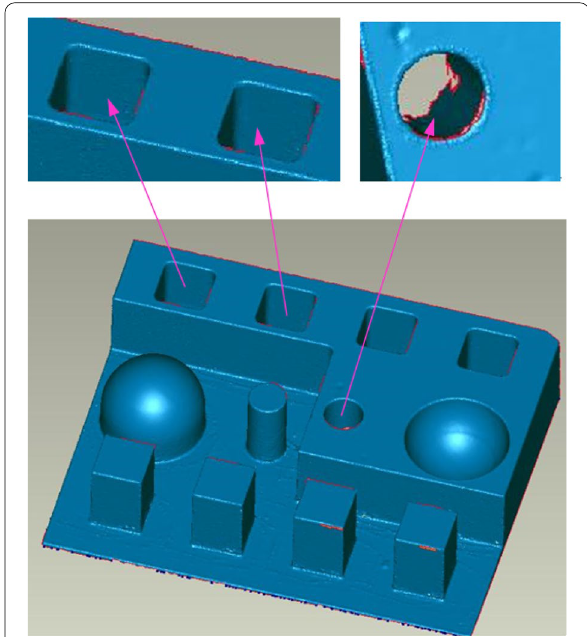
Figure 9 The shaped form of the measured data and the indication of some areas where cannot be